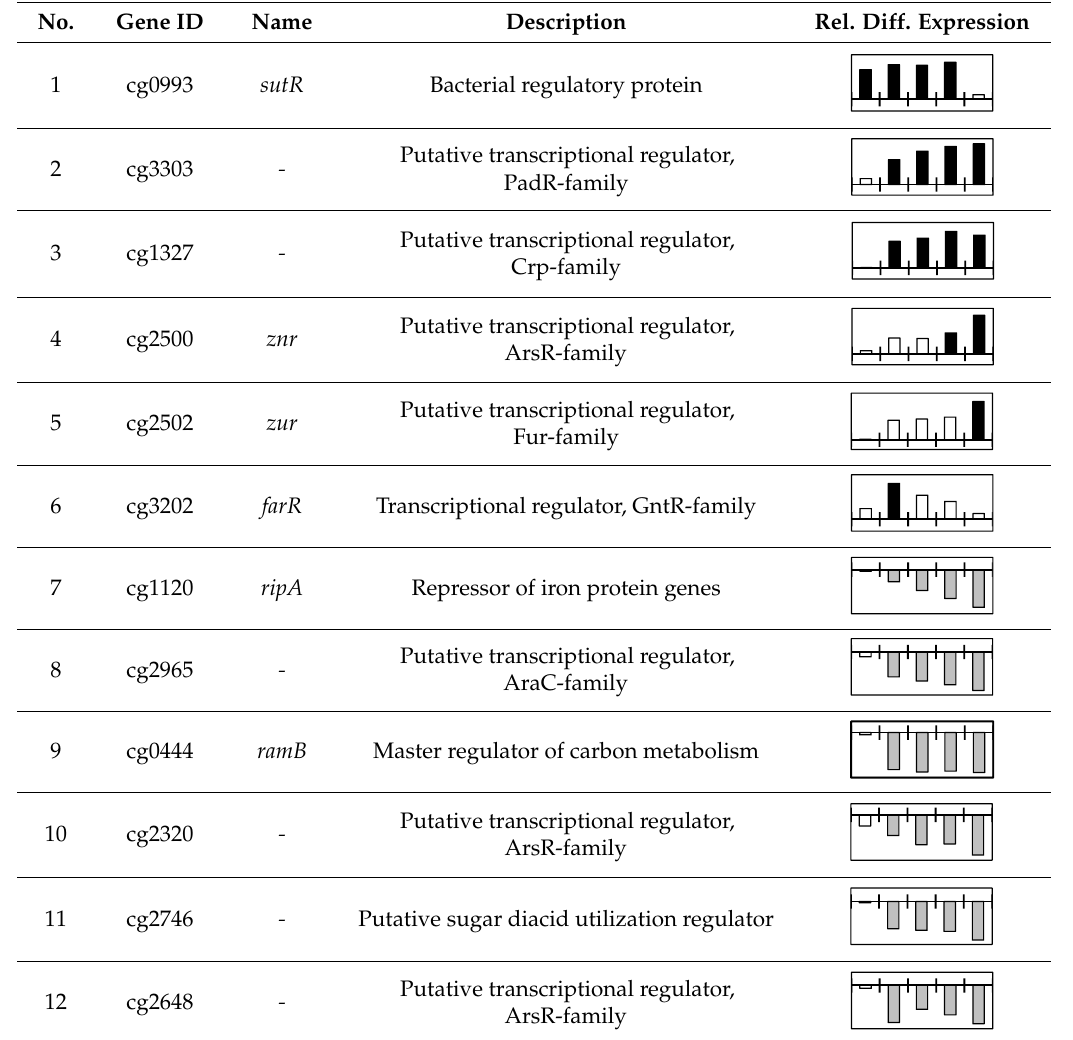
ECF sigma factor controlling the expression of disulfide